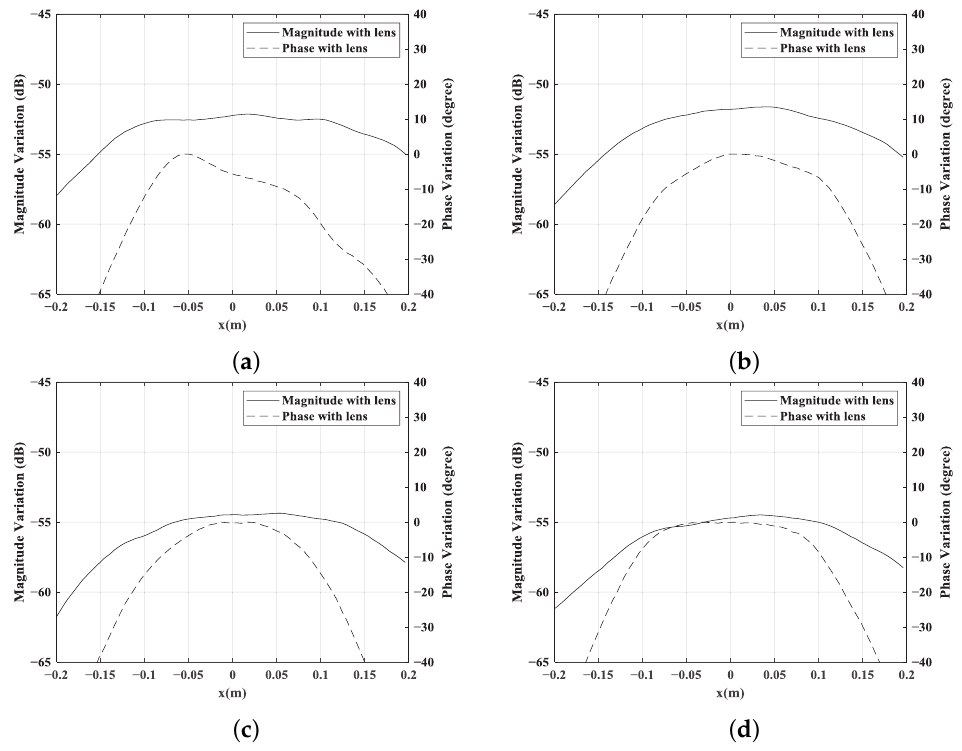
Figure 10. Measured amplitude and phase distribution of the feeding-antenna array with the meta- surface lens in the QZ: ( a ) f = 24.25 GHz, ( b ) f = 25 GHz, ( c ) f = 26 GHz, and ( d ) f = 27.5